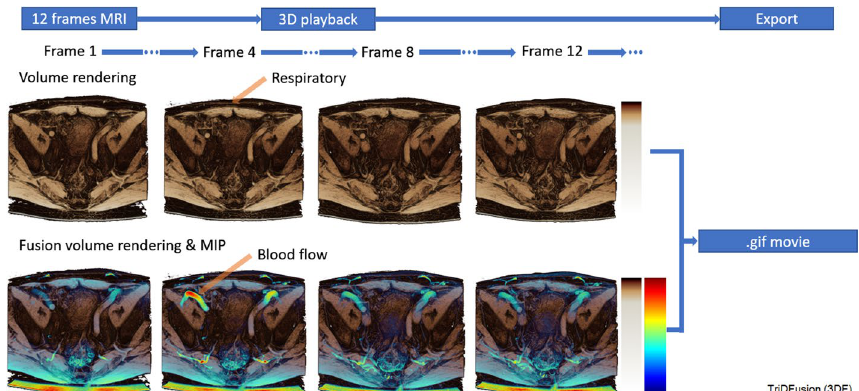
Fig. 3 A three-dimensional volume rendered view of a four-dimensional magnetic resonance imaging sequence of the soft tissue in the pelvis (row 1) fused with a maximum intensity projection (row 2) to simultaneously highlight respiratory motion and blood flow